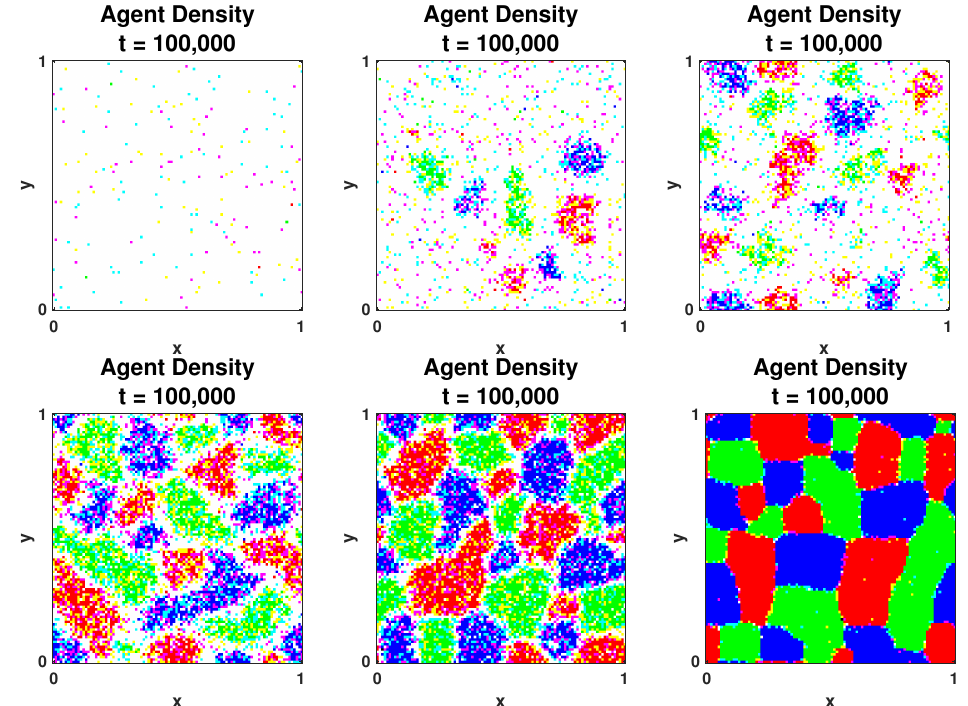
Figure 4. Agent density lattices taken after 100,000 time steps for different β values for = 1, and N = N = N = 50,000 agents. Starting from the top left, the re- δ t = 1, L = 100, γ 2 3 1 λ sulting order parameter was around 0,0.20, 0.39,0.69,0.83, and 0.96, respectively. The β values used were 5 × 10 − 6 ,9.4 × 10 − 6 ,1 × 10 − 5 ,1.2 × 10 − 5 ,1.4 × 10 − 5 and 3 × 10 − 5 , respectively. The critical β value is around 9.3 × 10 − 6 . We clearly see when the order parameter is between 0.1 and 0.9, then the system is in a partially segregated state. The territories formed also become more evident as β increases, which also results in the order parameter value becoming